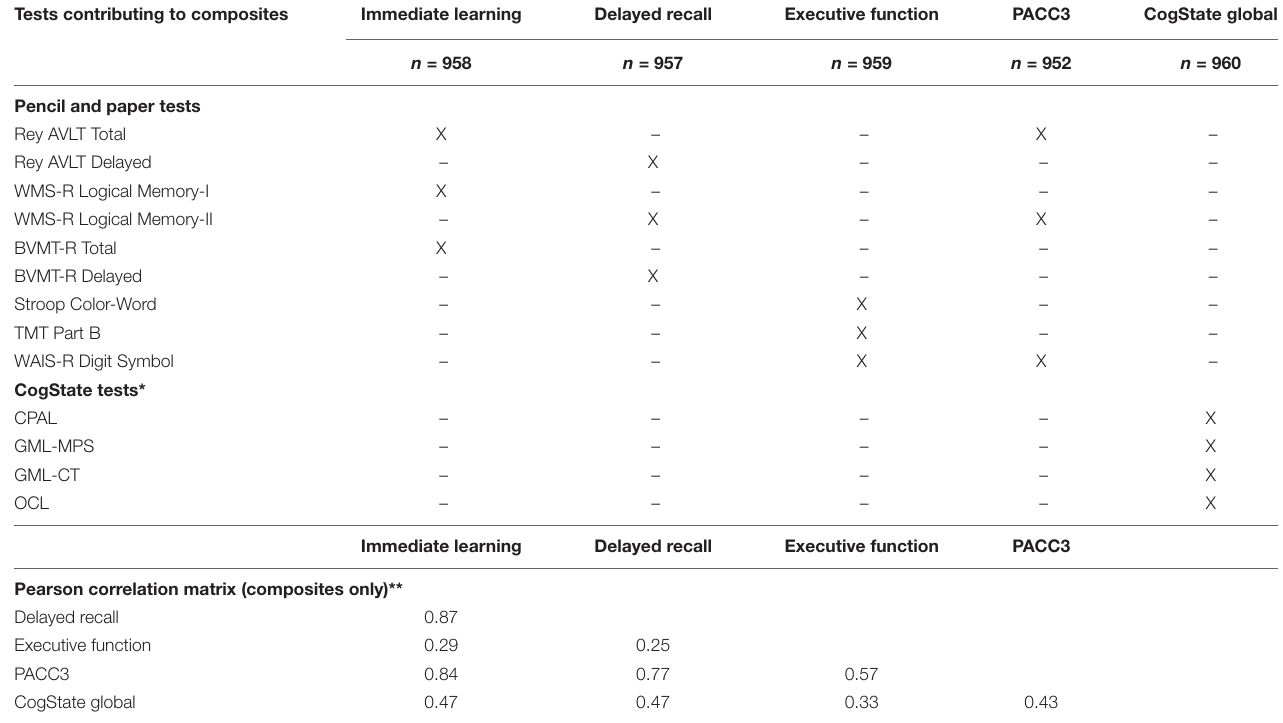
TABLE 1 | Neuropsychological tests contributing to cognitive composites and correlations among